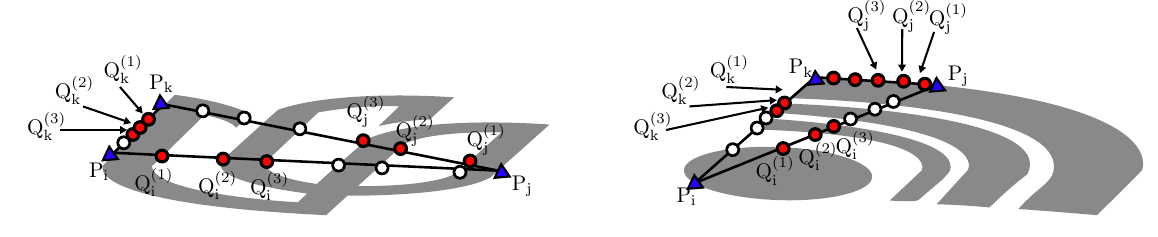
Figure 7. Significantly severe deformations bring inaccurate points into the new